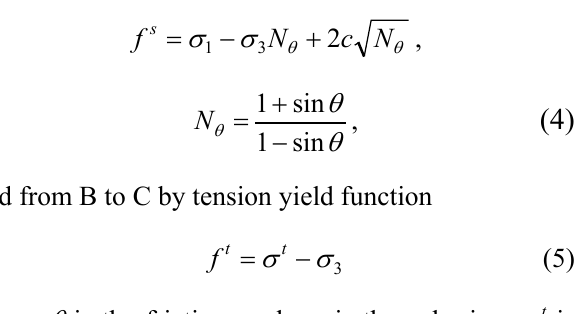
Fig. 7. The Mohr–Coulomb failure criterion in FLAC (Itasca [9]) The failure envelope is defined from point A to point B by the Mohr–Coulomb (shear) yield